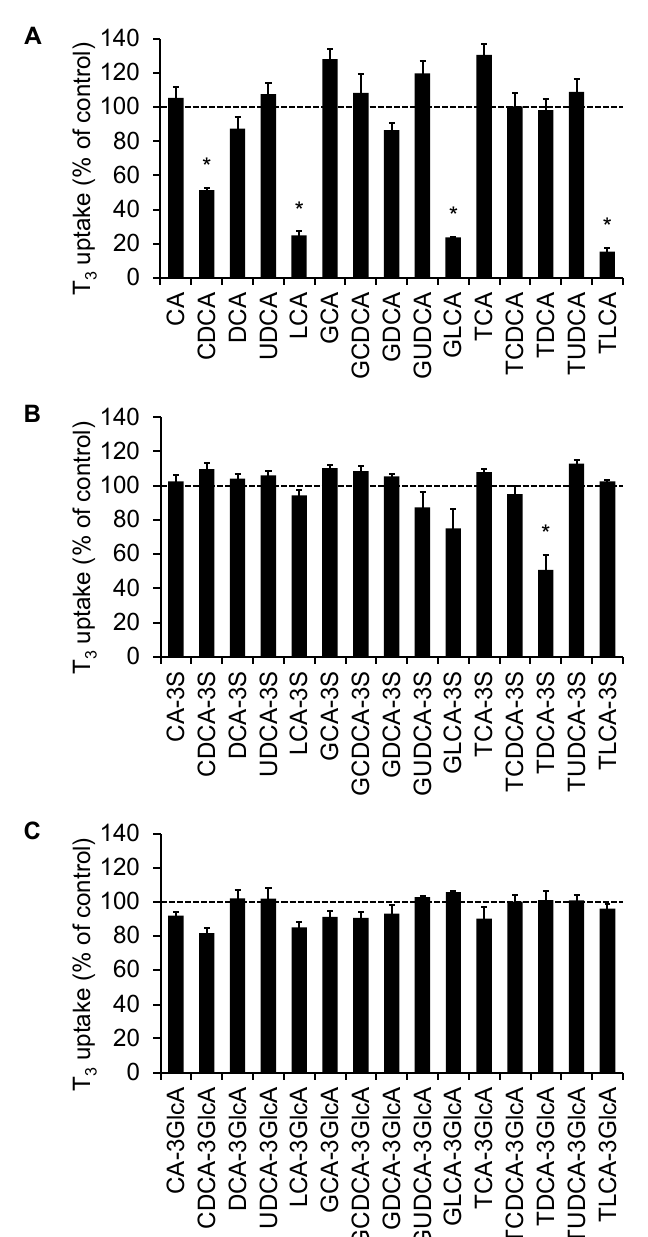
Figure 2. Inhibitory effect of 45 bile acids on OATP4C1-mediated T 3 transport. ( A ) unconjugated, glycine-conjugated, and taurine-conjugated bile acids, ( B ) bile acid 3-sulfates, and ( C ) bile acid 3-glucuronides. The T 3 concentration was 1 µM and cells were incubated for 10 min at 37 °C. The bile acid concentrations were 50 µM for CA-3S, LCA-3S, TDCA-3S, LCA-3GlcA, and GLCA-3GlcA, and 100 µM for the other 40 types of bile acids. The OATP4C1-mediated transport was calculated by subtracting the nonspecific uptake of T 3 by the mock cells from the total cellular uptake by the OATP4C1-expressing cells. Each column and bar represent the mean ± standard error of the mean ( n = 3). The data are shown as the percentages of transport relative to the control. An asterisk indicates a significant difference from the control by one-way analysis of variance (ANOVA) followed by Tukey’s test ( p < 0.05).